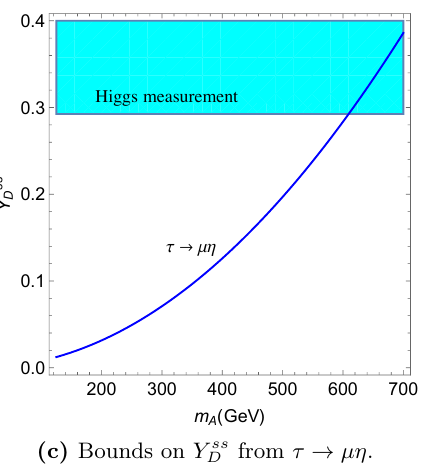
, Y dd and Y ss from (cid:28) (cid:22)P U D D !